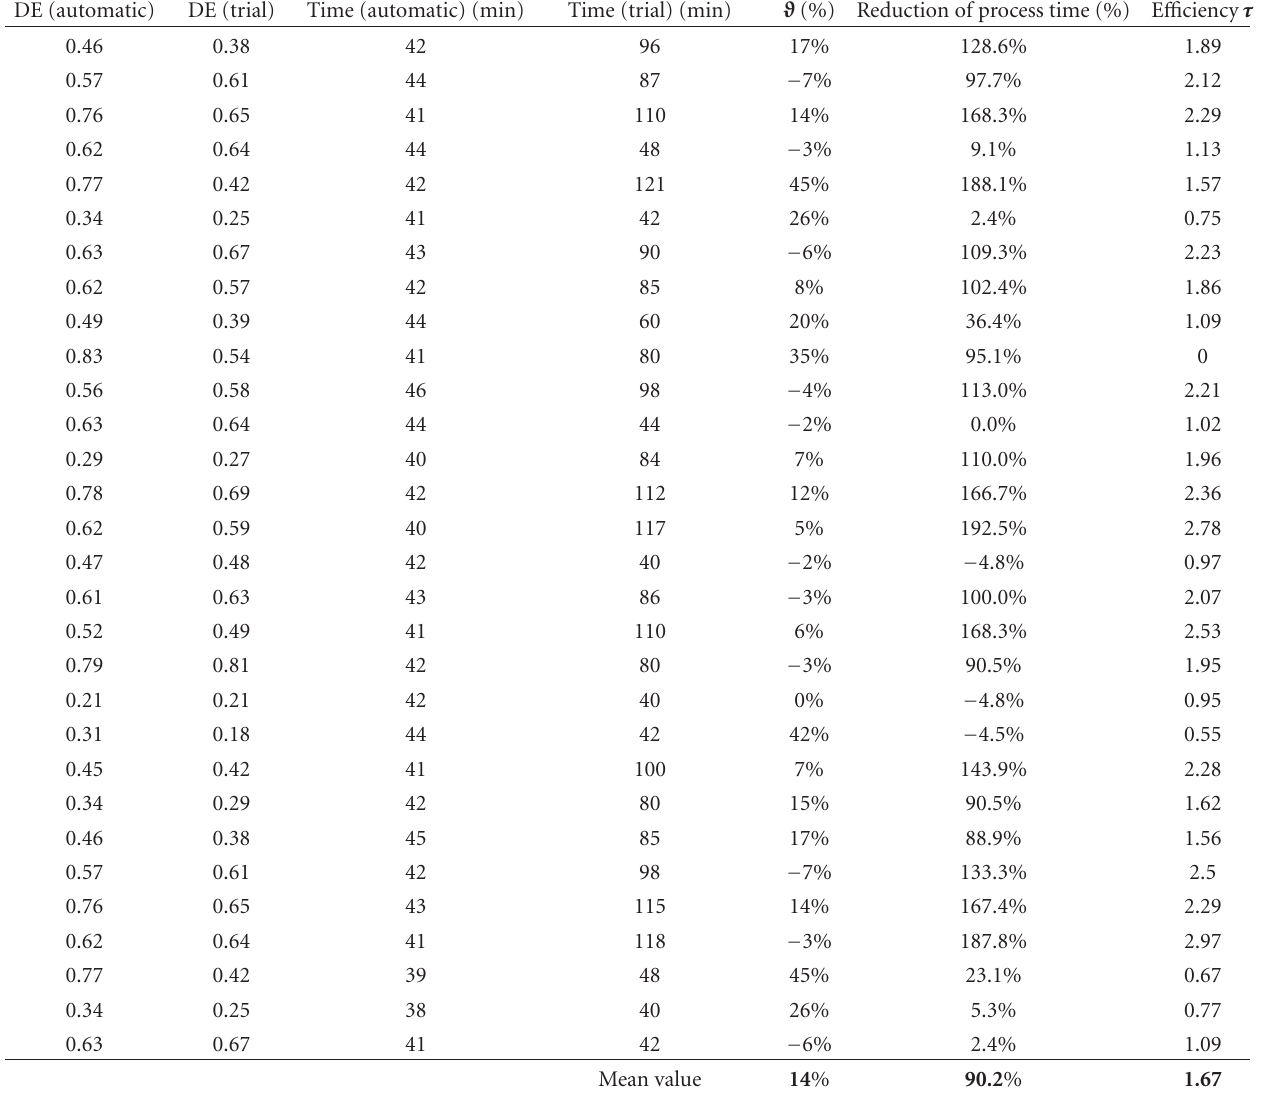
Table 2: Software performance for some